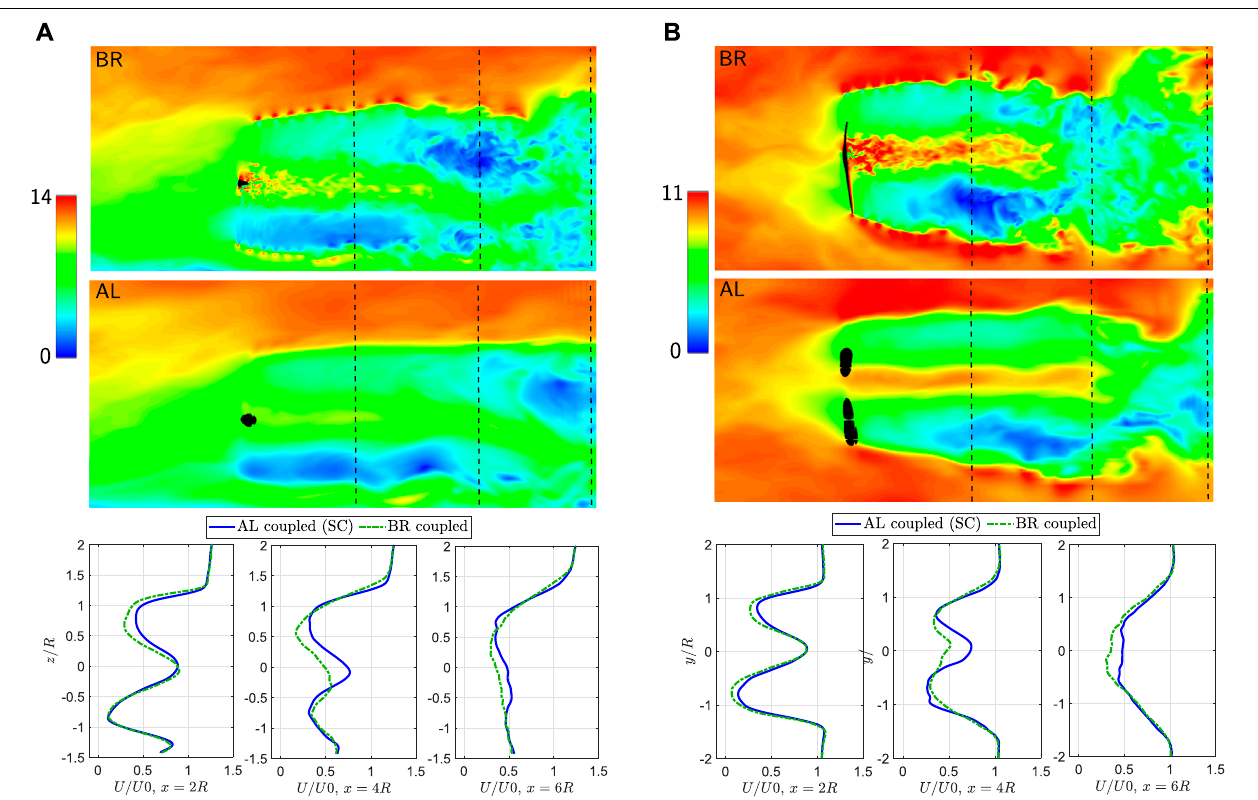
FIGURE 9 | Case 4: High shear, low yaw and turbulence. Instantaneous velocity magnitude at centreline planes and mean velocity plots at marked locations. Blades shown by surface mesh for BR, and iso-surface of applied body force for AL. (A) Vertical plane and vertical mean velocity profiles. (B) Horizontal plane and horizontal mean velocity